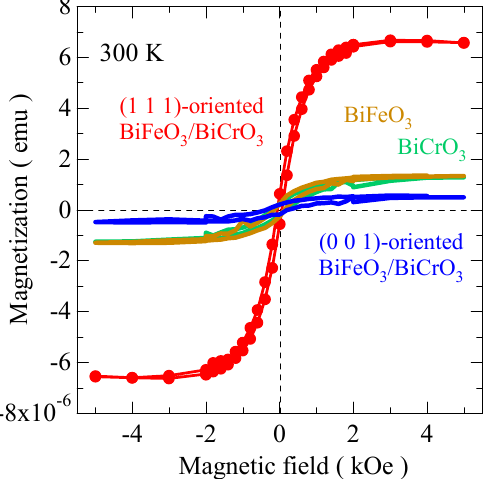
/BiCrO Figure 10. Magnetization curves measured at 300 K of 4-monolayer BiFeO 3 3 artificial superlattice grown on SrTiO (1 1 1) substrate (red). Those of 4-monolayer 3 BiFeO /BiCrO artificial superlattice grown on SrTiO (0 0 1) substrate (blue), and 3 3 3 4-monolayer BiFeO (brown) and 4-monolayer BiCrO (green) thin films grown on SrTiO 3 3 3 (1 1 1) substrates are also shown. Only the (1 1 1)-oriented BiFeO /BiCrO artificial 3 3 superlattice shows the large magnetization, confirming the ferromagnetic property of the film.